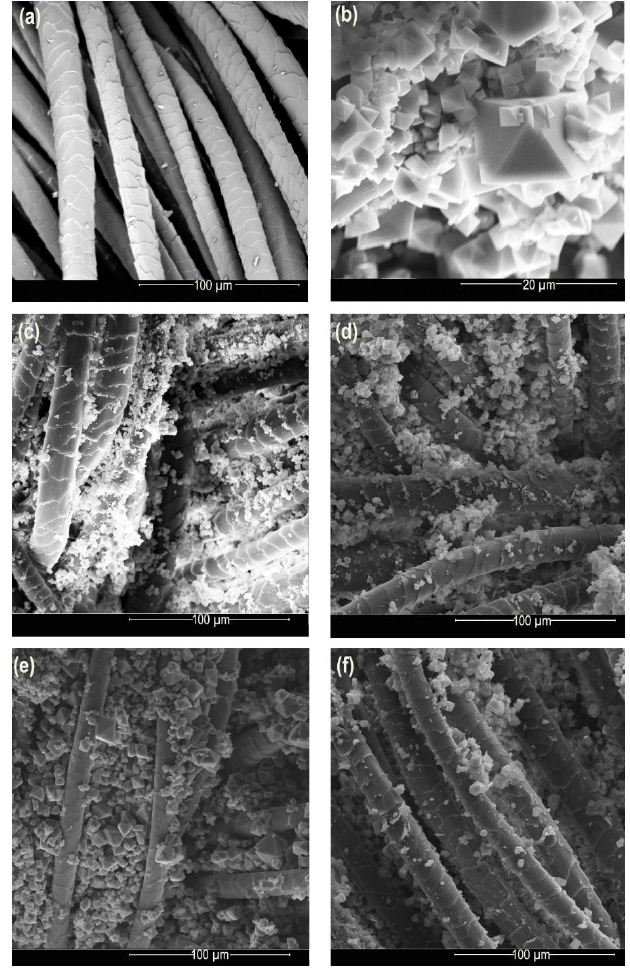
Figure 3. SEM of: ( a ) woolen fabric (untreated); ( b ) HKUST-1; wool@HKUST-1 synthesis of: ( c ) 24 h; ( d ) 24 h washed; ( e ) 48 h; and ( f ) 48 h washed.